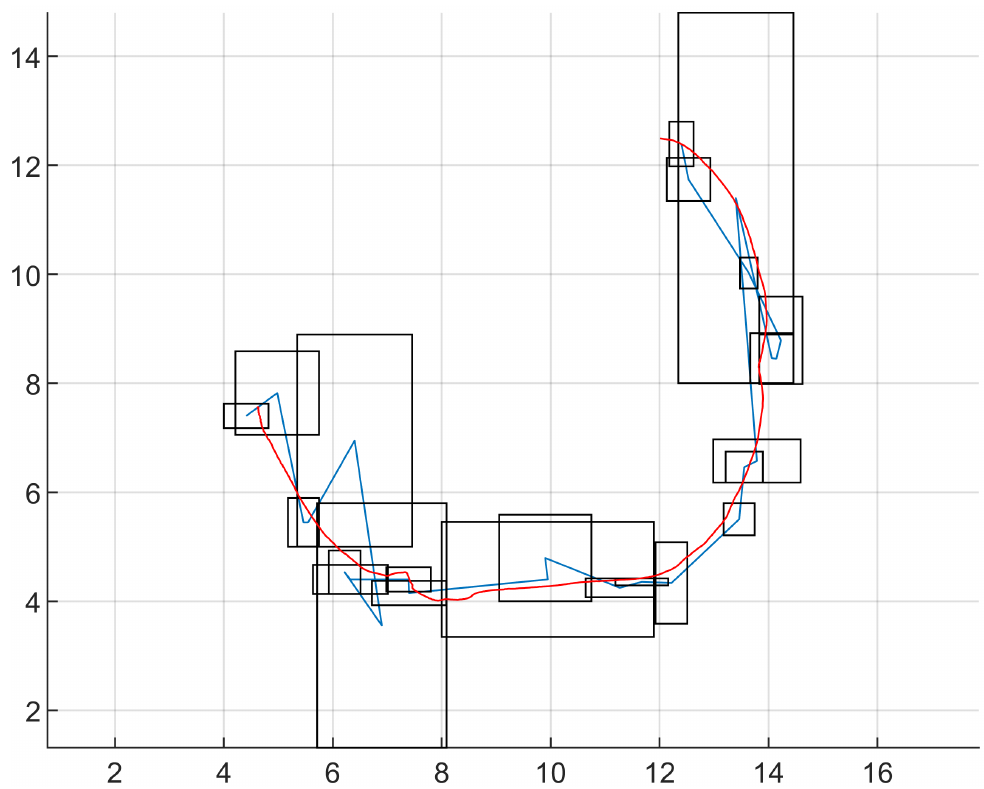
Figure 12. Example of test of the position estimation. The red curve represents the actual trajectory of the robot obtained by the vision system. The blue curve represents the trajectory estimated through the robot internal localization system. The black rectangles represent the accuracy along the x and y coordinates for each estimated robot pose. Horizontal and vertical axes units are normalized to the pitch of the square contacts ( v + w ).